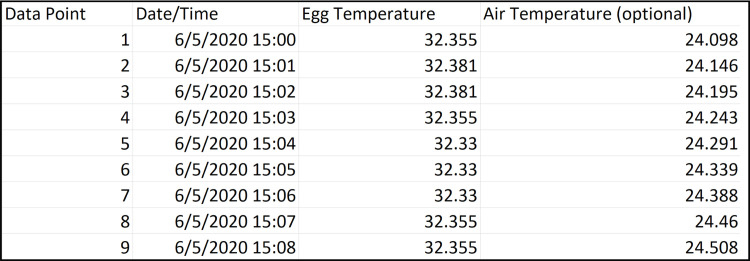
Example input file.